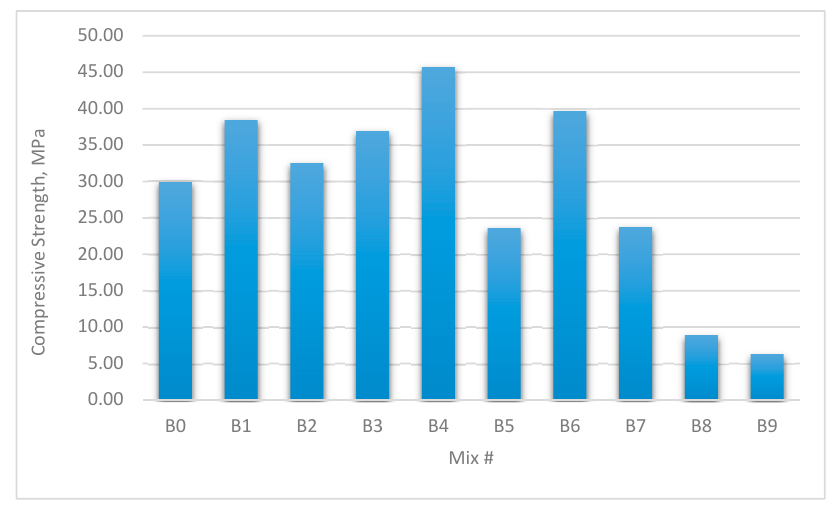
Figure 4. Compressive strengths of concrete cubes with W/B ratio 0.35.